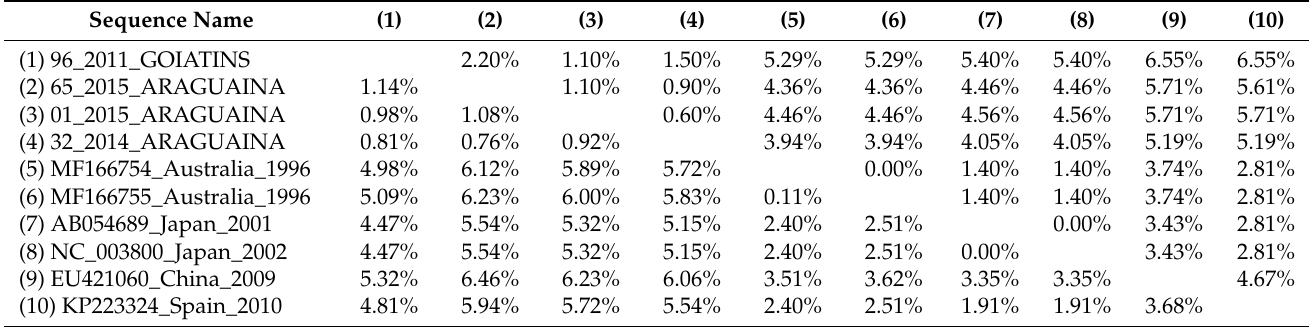
Table 1. Distances of the translated segment 1 and segment 2 of